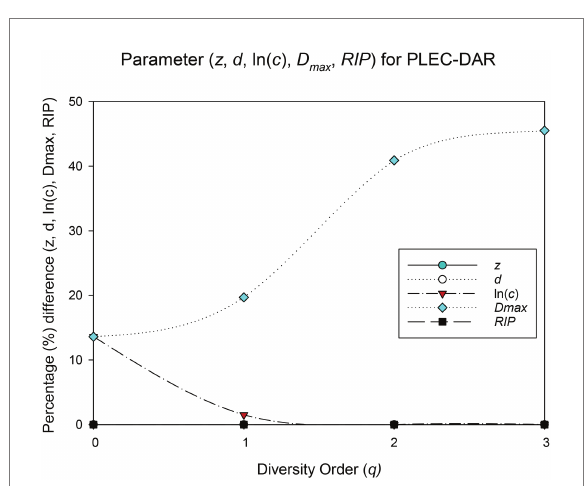
FIGURE 2 Results of randomization test: The percentage of pairwise comparisons with significant difference in the PLEC-DAR model parameters.